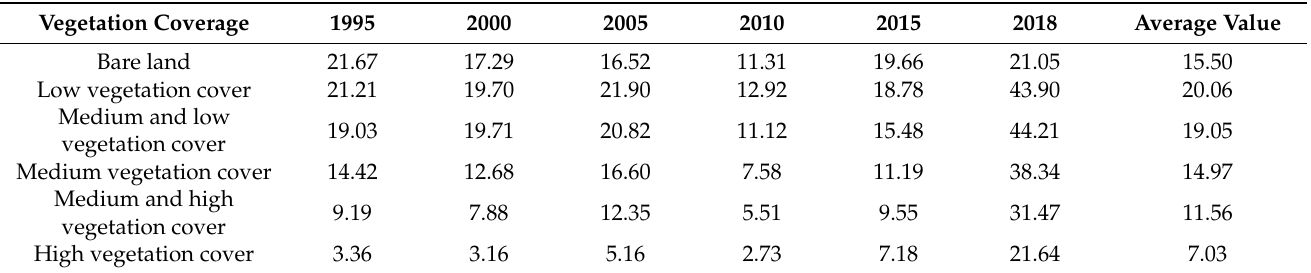
Table 5. Modulus of soil erosion in different years under different vegetation coverage in the South and North Mountains of Lanzhou (unit: t/(km 2 · a)).